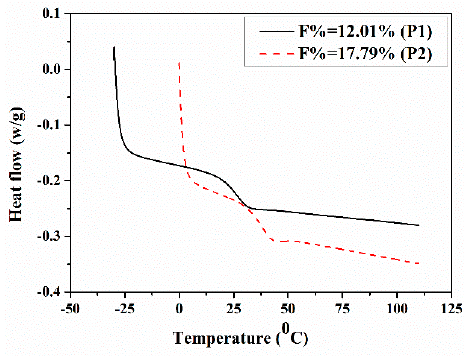
Figure 6. Differential scanning calorimetry (DSC) curves of fluoropolymers P1 and P2 .